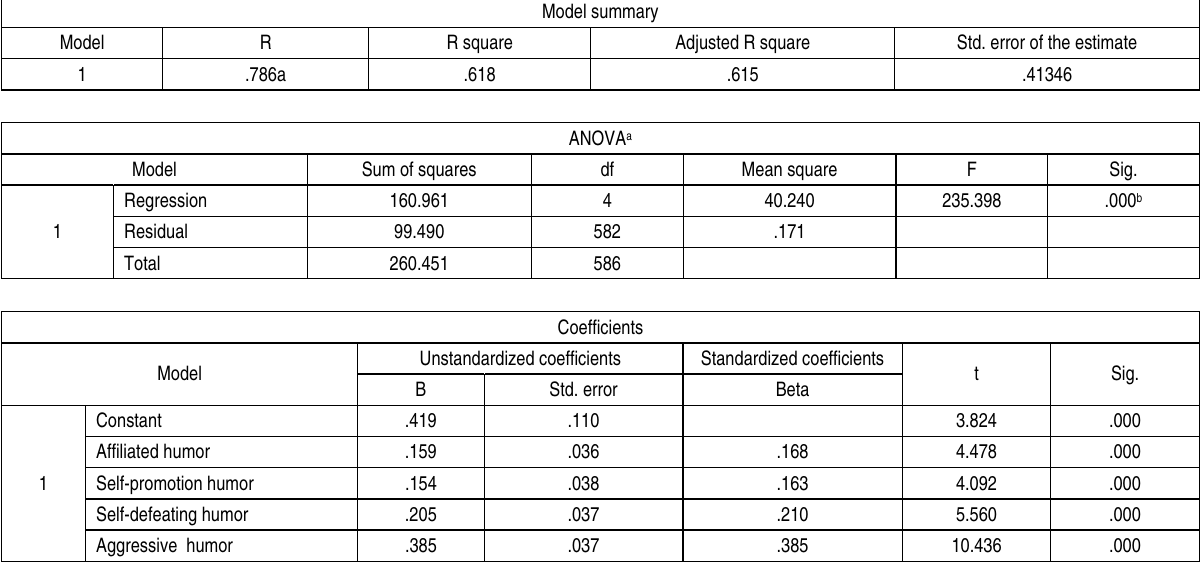
Table 10. Humor advertisement has significant impact in airlines customers’ mental